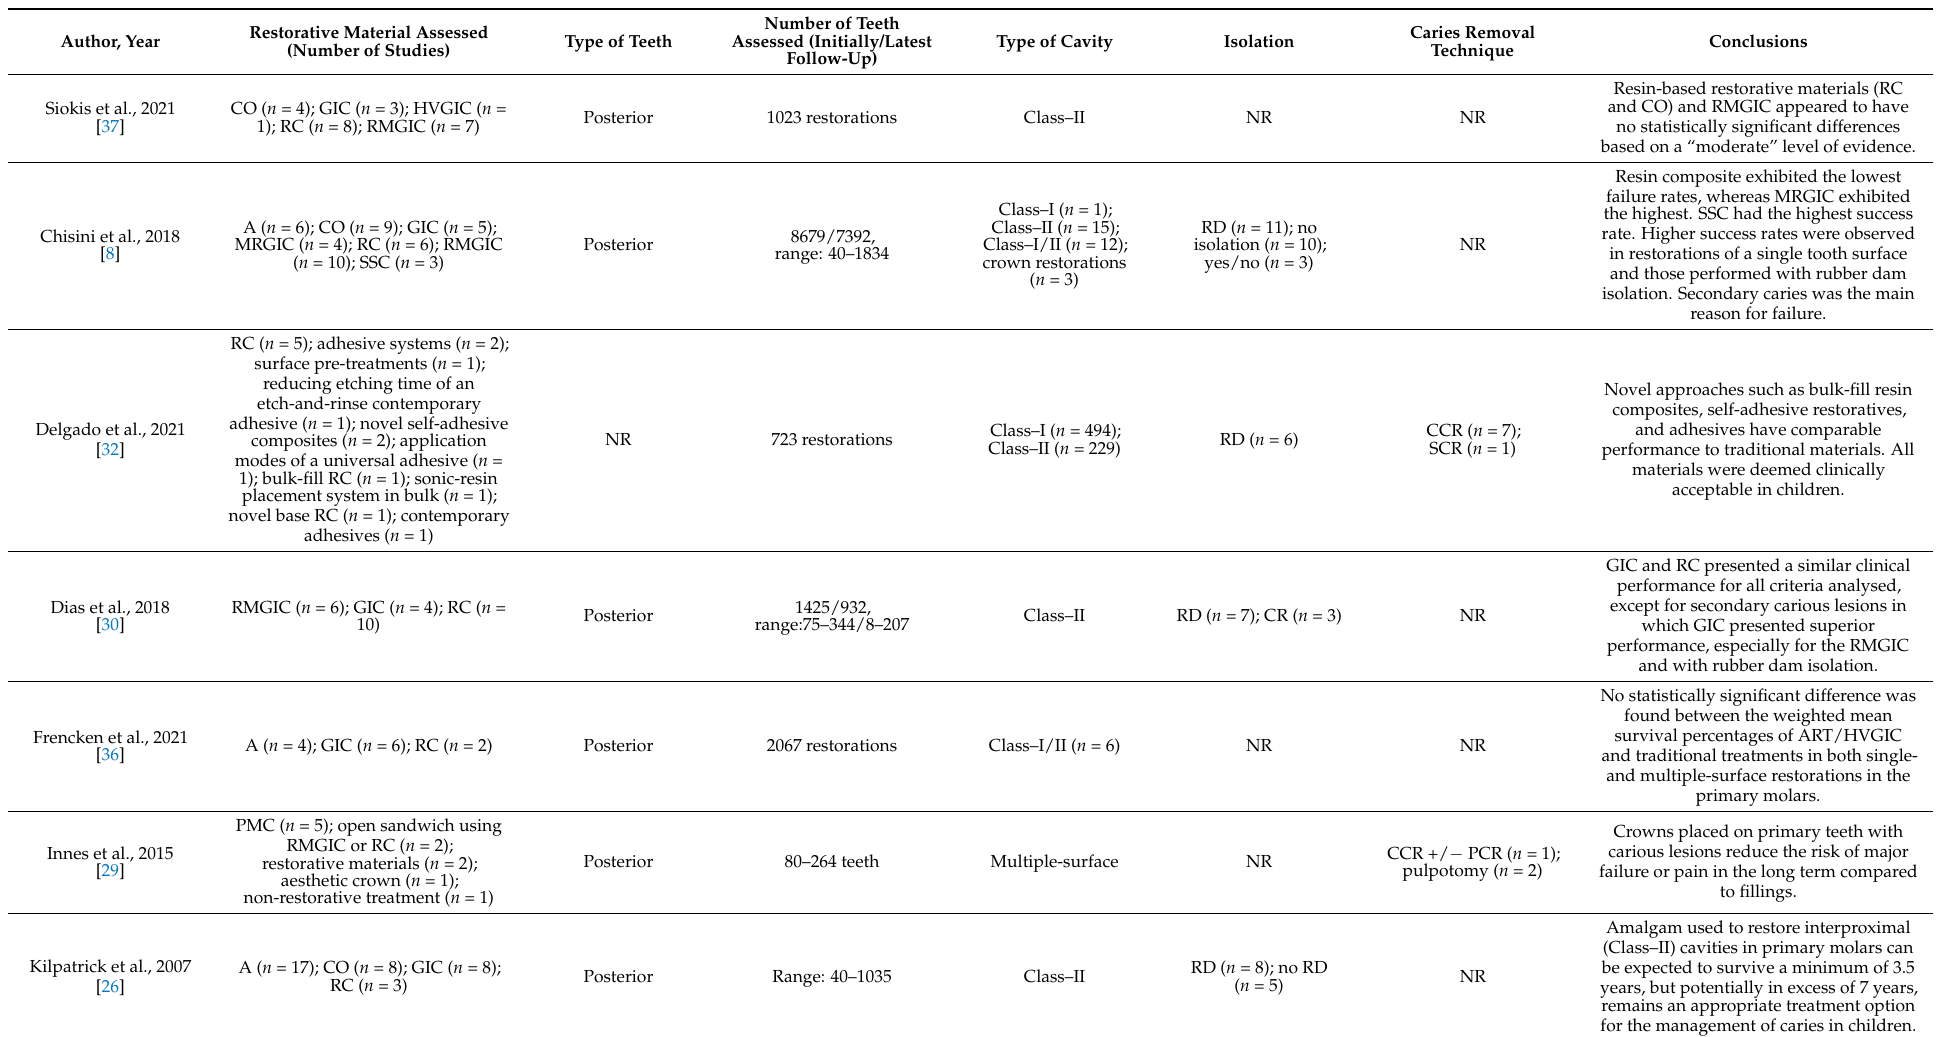
Table 3. Main conclusions drawn from the included